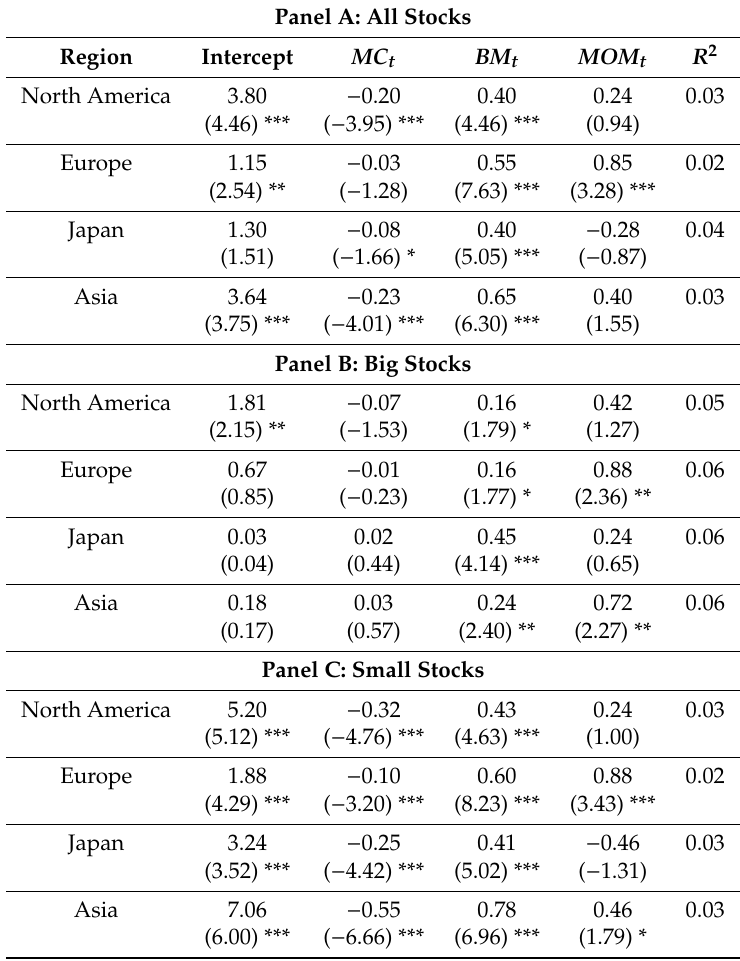
Table 1. Baseline Regressions. This table lists the results of Fama–MacBeth regressions using data representing twenty-three countries divided into the regions of North America, Europe, Japan, and Asia over the period 1991–2016. Market capitalization ( MC t ), log book-to-market equity ( BM t ), and momentum ( MOM t ), all observed at time t , are used to predict t + 1 returns in excess of the one-month Treasury rate. MC t is the time t price multiplied by shares outstanding. MOM t is the cumulative return measured over month t − 12 to t − 2, and BM t is the book equity divided by market equity both observed in month t − 6. R 2 is the average R-squared across all months. Values in parentheses are Newey–West t-statistics. Results in Panel A are based on the set of all stocks within each region. Panel B results are based on the set of big stocks defined as the stocks with the largest market capitalization comprising 90% of the total market capitalization, and Panel C results are from the set of small stocks which consists of the smallest market capitalization stocks that aggregate to 10% of the total market capitalization. *** / ** / * indicates significance at the 1, 5, and 10% level,